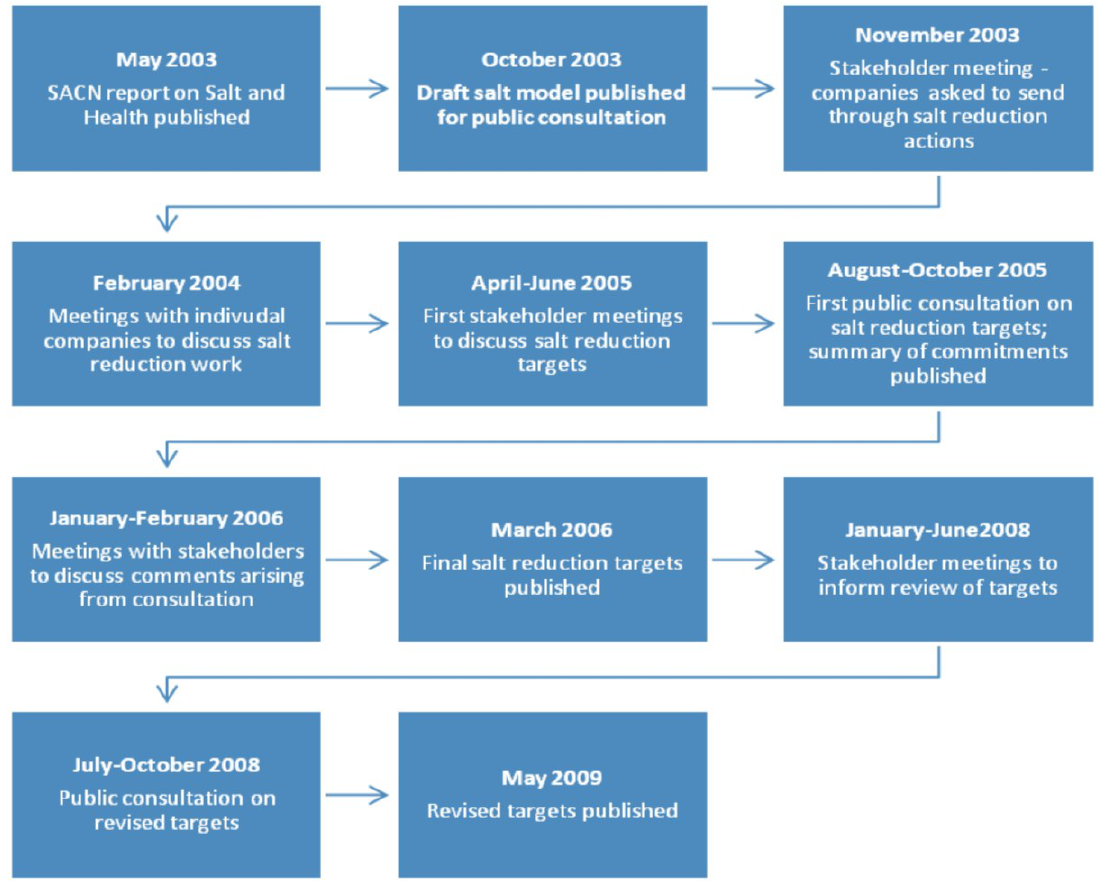
Figure 1. Summary of the UK Food Standards Agency’s engagement with the food industry to develop salt reduction targets, 2003 to 2009. SACN, Scientific Advisory Committee on